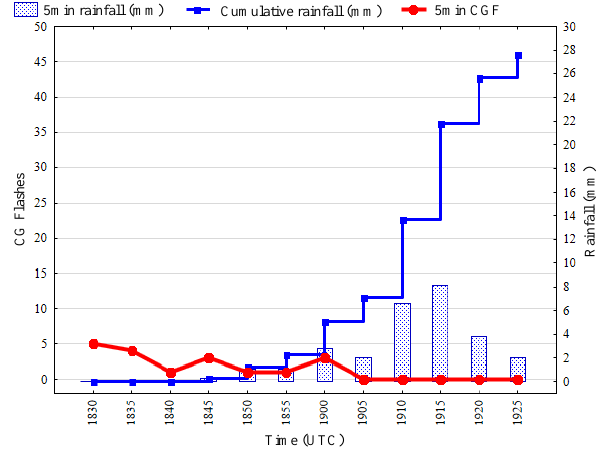
Figure 9. Critical interval time series for debris flow event of 17 Au- gust 1998. This is an event from the STH group and debris flow initiation was observed at 19:25UTC.